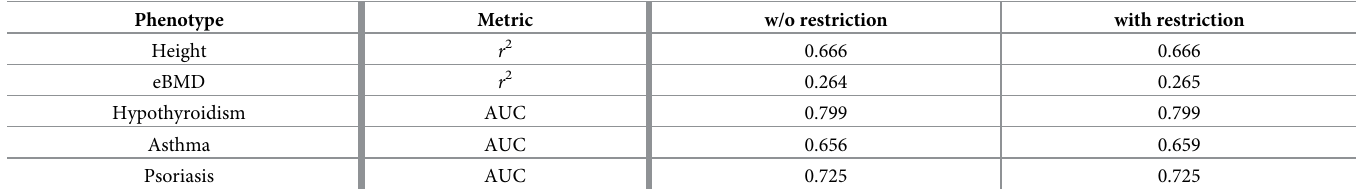
Table 1. Performance of depth-2 XGBoost prediction models with or without restricting gene-covariate interactions. Phenotype